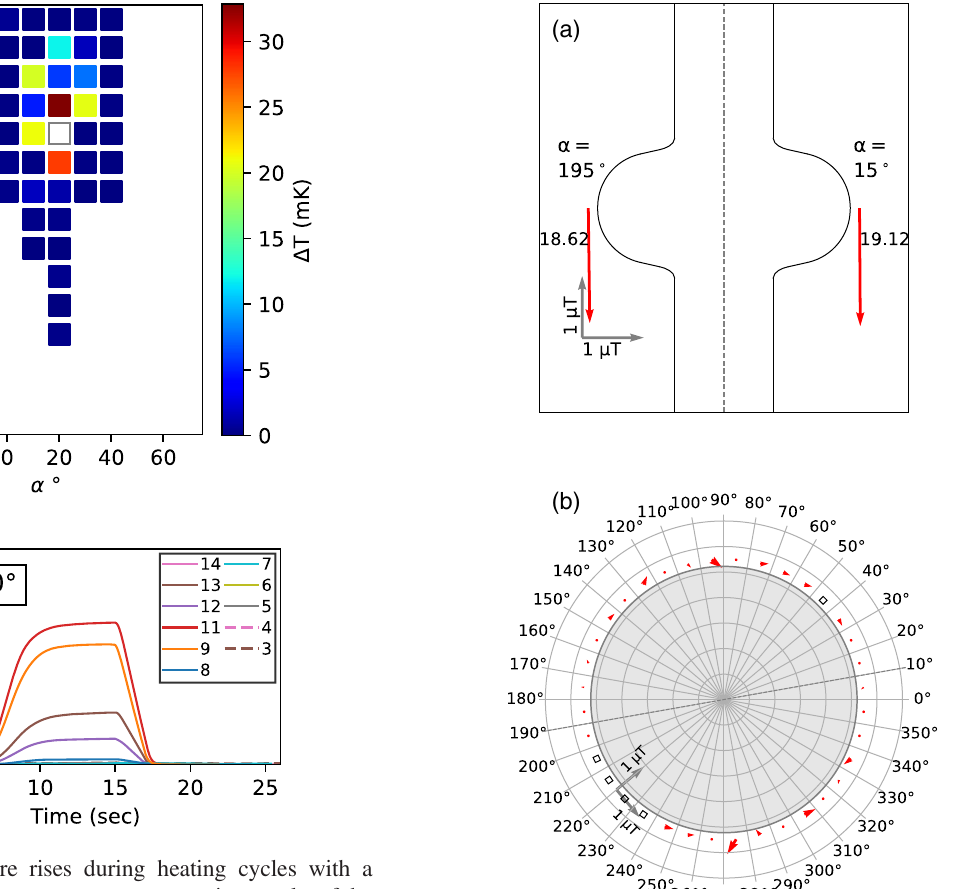
Figure 9 indicates that the magnetic field was expelled axisymmetrically and uniformly with respect to the z -axis.